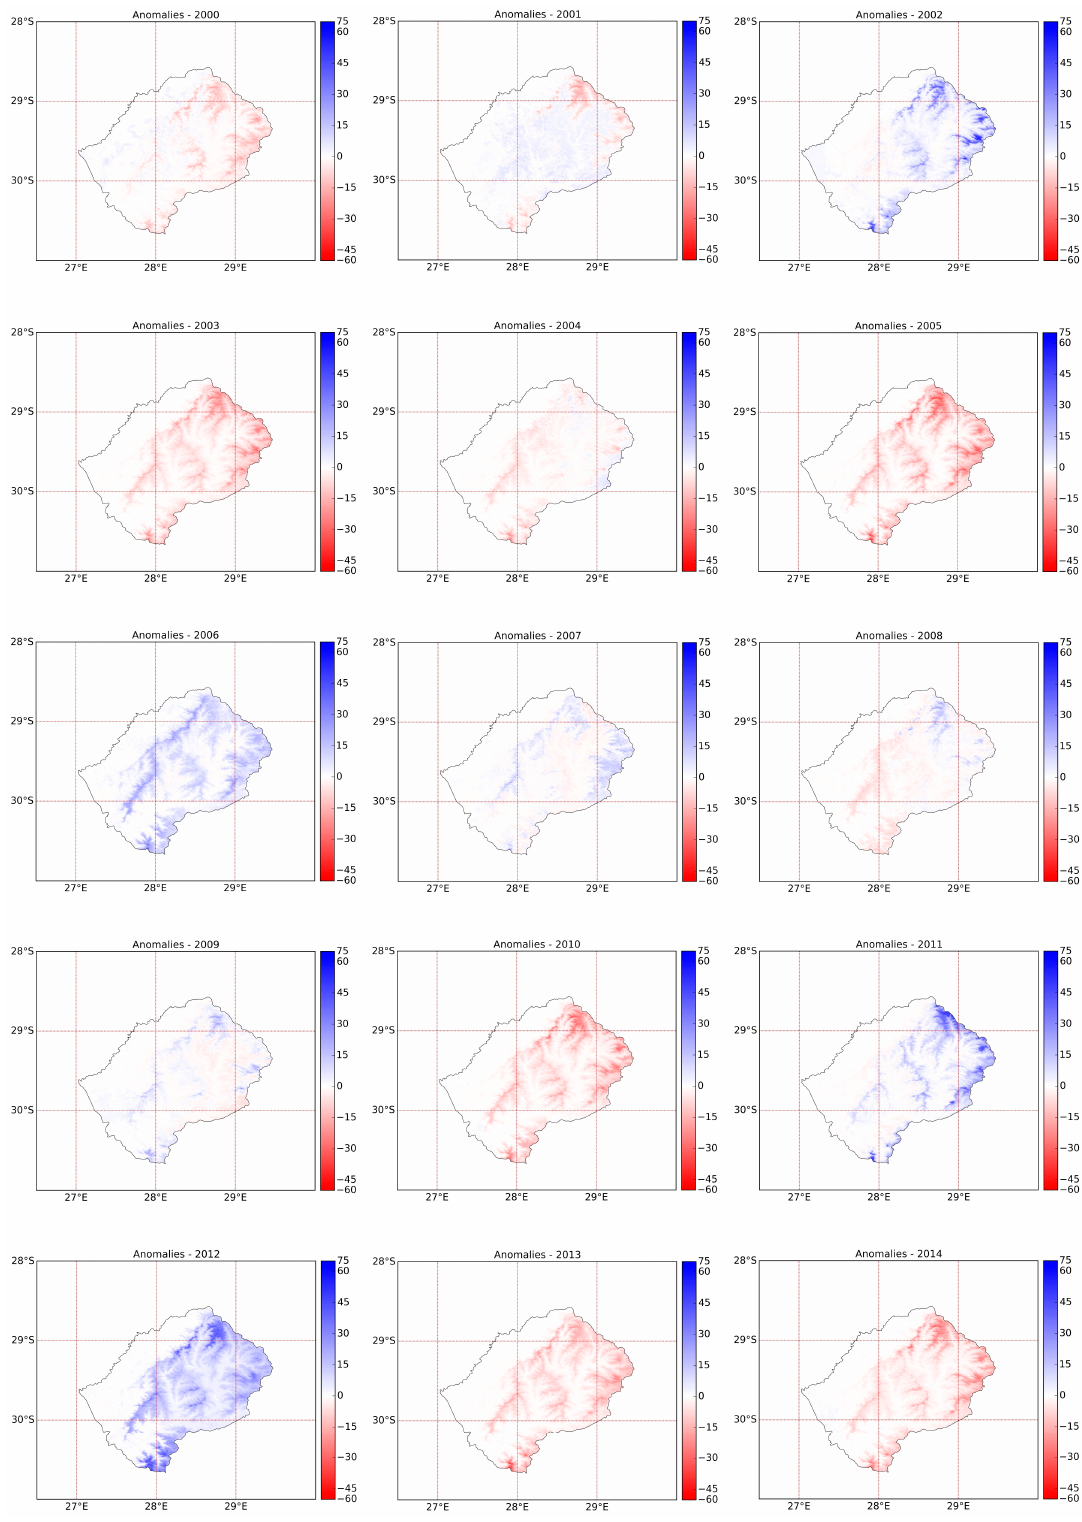
Figure 8. Annual snow cover anomalies as annual departures from the long term mean (in days) for Lesotho based on daily snow maps retrieved from MODIS MOD09GA data. The scaling in the ranges +60–75 days and –45–60 days is compressed to stretch the range with the highest probability. The reference period for calculating the anomaly is 2000–2014.